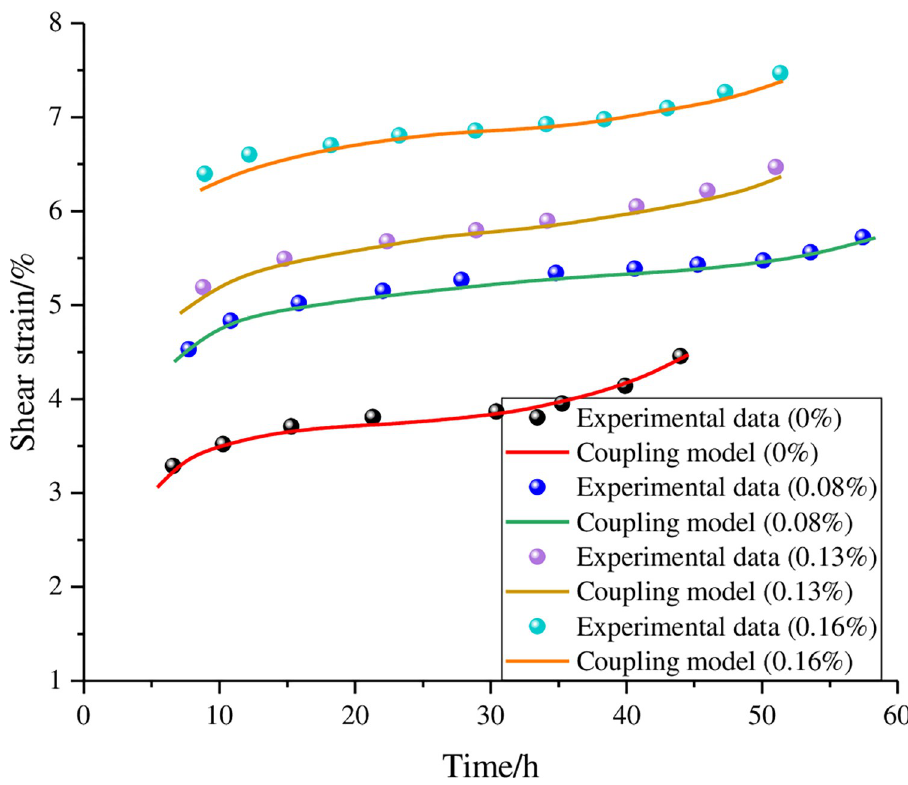
Fig 14. Steady-state phase fitting